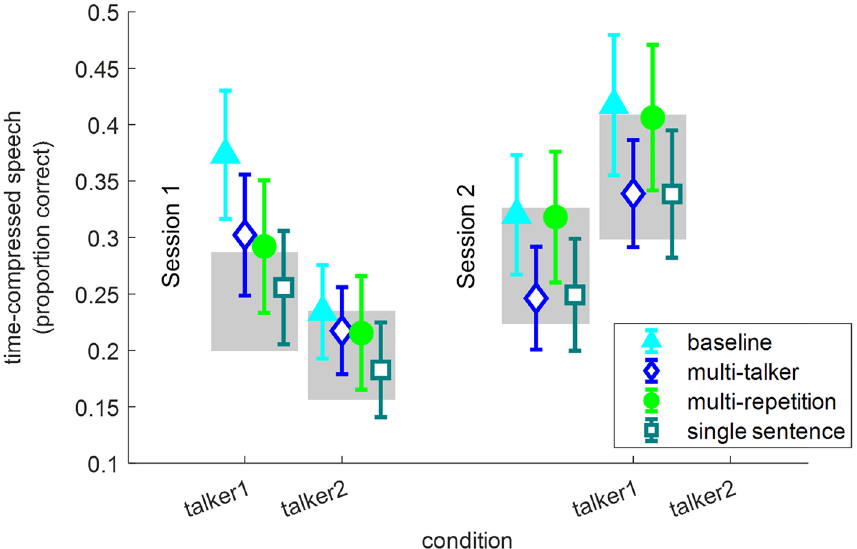
Figure 7. Time-compressed speech recognition by rapid-learning condition in the immediate (Session 1) and delayed (Session 2) tests. For each rapid-learning group the mean (across all sentences per condition) and 95% confidence interval are shown. The grey rectangles mark the 95% confidence interval of the control group who participated in testing only.